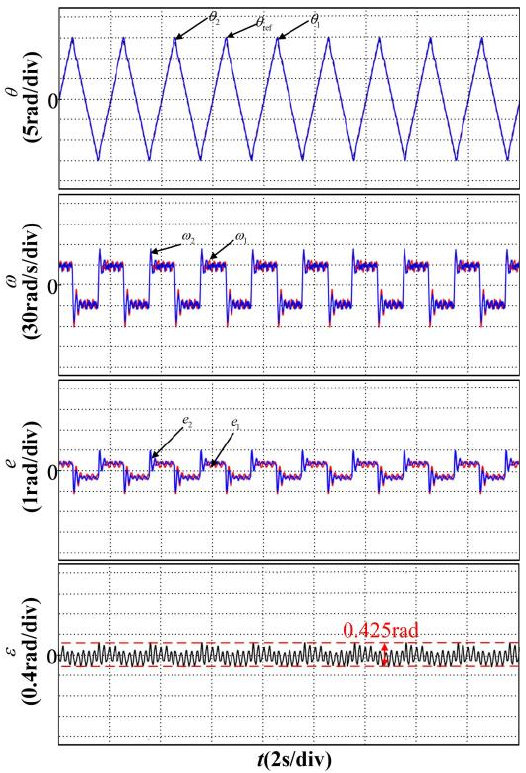
Figure 16. Motor responses when J changes.